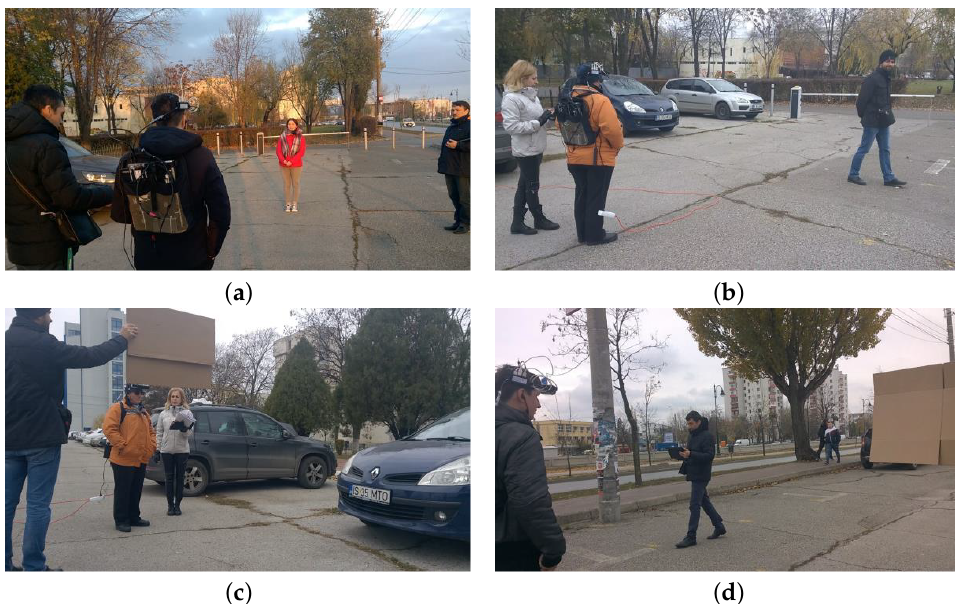
Figure 3. Examples of testing scene setups for perception tests with generic objects: ( a ) Scene with generic static objects (PT I-1); ( b ) scene with generic static and dynamic objects (PT I-2); ( c ) scene with generic static and elevated objects (PT I-3); ( d ) scene with generic static, dynamic and elevated objects (PT I-4).